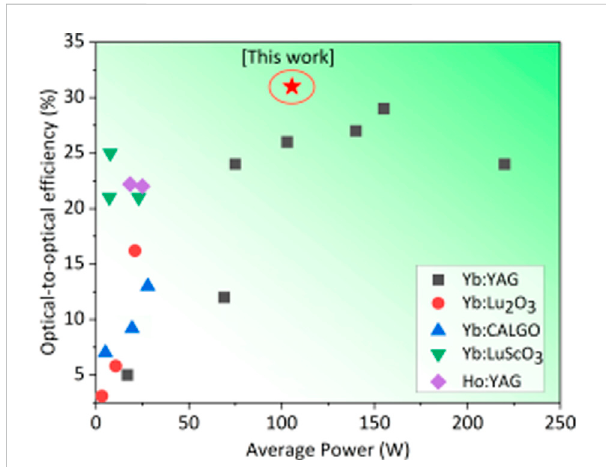
FIGURE 1 Overview of optical-to-optical ef fi ciencies and average power for various mode-locked thin-disk oscillators with pulse the duration less than 300 fs [11 – 29].